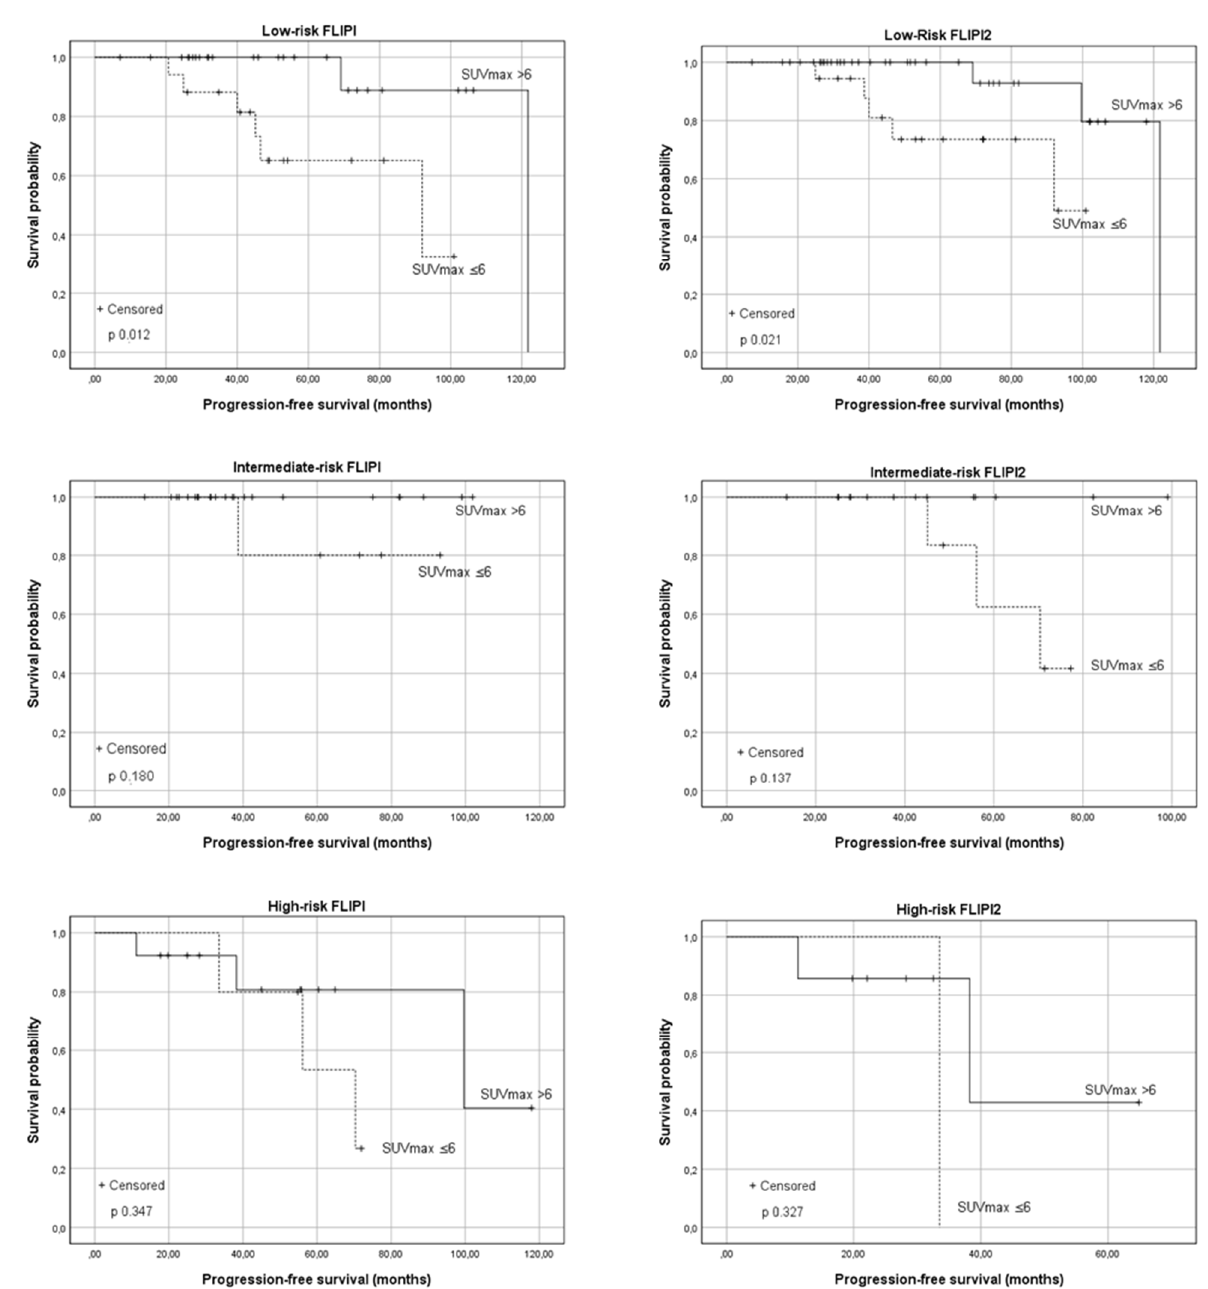
Figure 3. The progression-free survival (PFS) according to the baseline SUV max in relationship to the Follicular Lymphoma International Prognostic Index (FLIPI) and Follicular Lymphoma International Prognostic Index 2 (FLIPI2) risk categories. From top to bottom: low-risk patients, intermediate-risk patients, and high-risk patients.